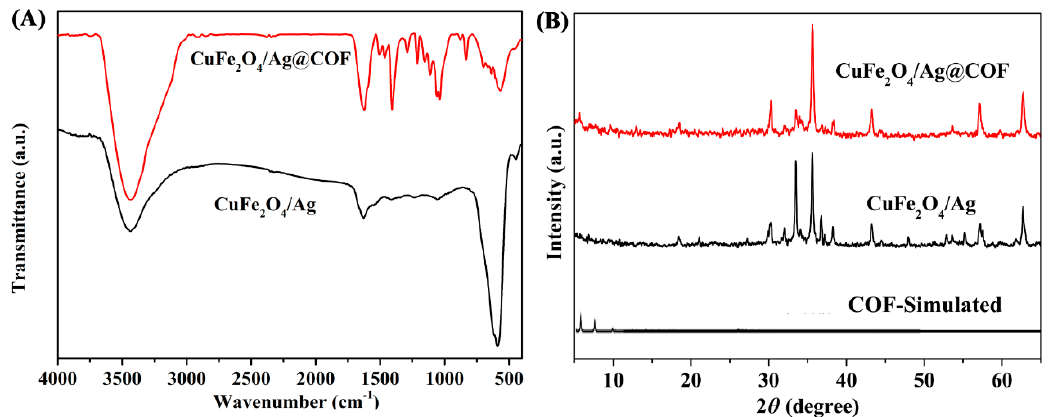
Figure 3. ( A ) Fourier transform infrared (FTIR) spectra of CuFe 2 O 4 /Ag and CuFe 2 O 4 /Ag@COF; ( B ) X-ray diffraction (XRD) patterns of CuFe 2 O 4 /Ag and CuFe 2 O 4